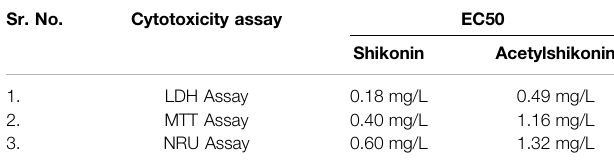
TABLE 7 | Cytotoxicity of shikonin and acetylshikonin against V79 cell lines (Figat et al., 2021). Sr.